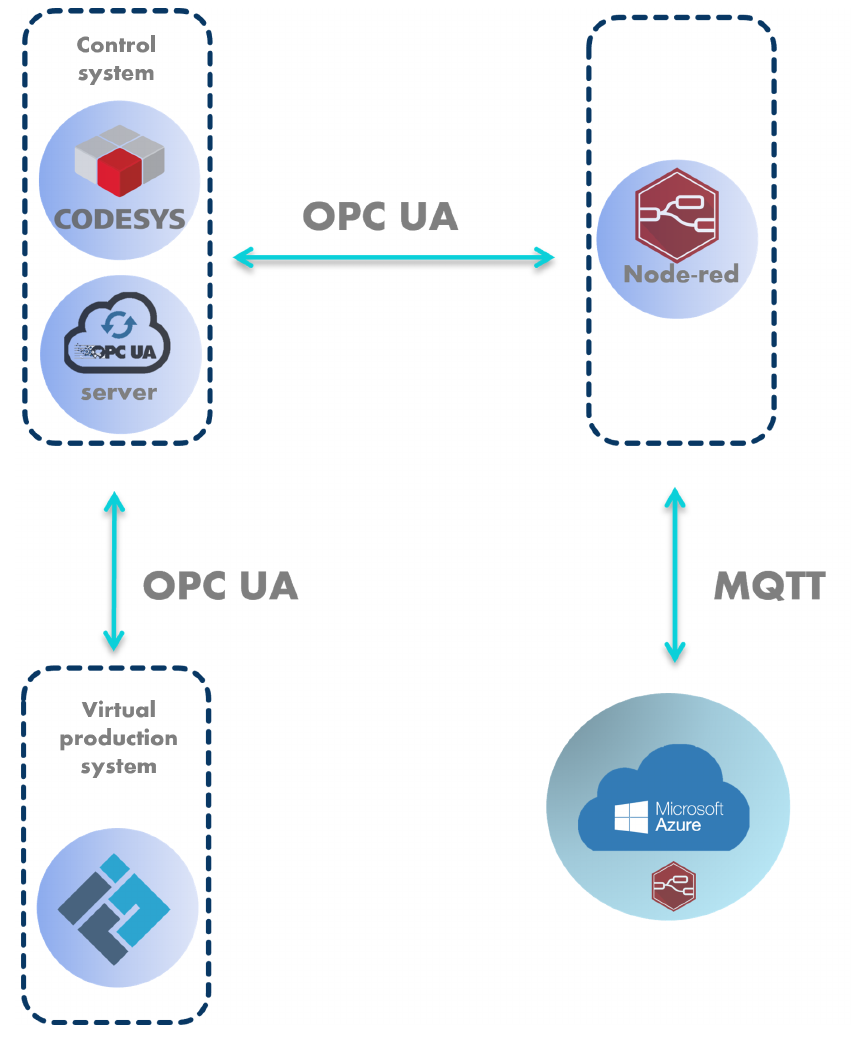
Figure 17. CODESYS linked with Node-RED and Microsoft